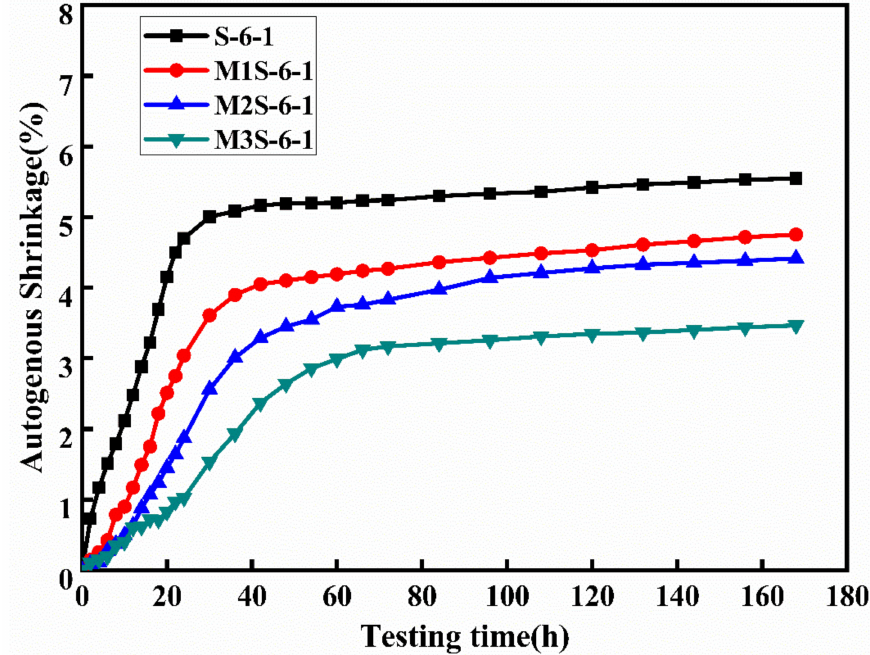
Figure 8. Effects of metakaolin on the autogenous shrinkage of alkali-activated slag